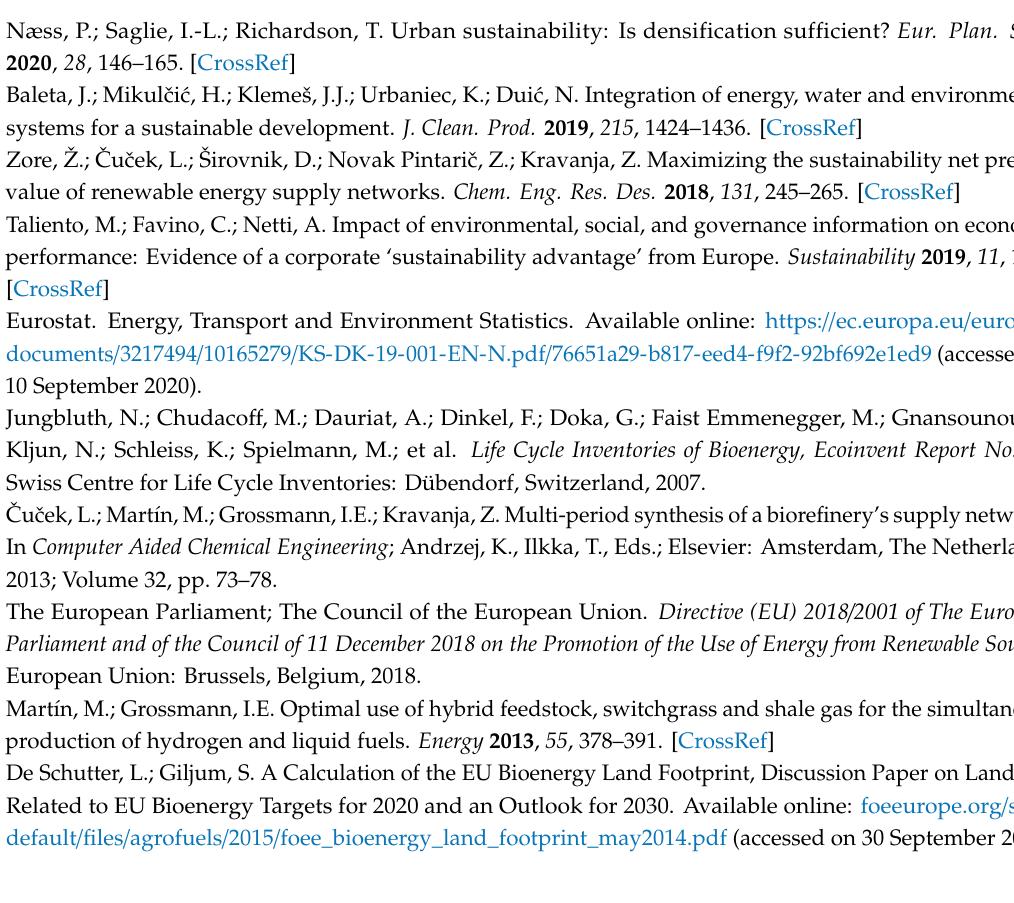
Table S1: Data for regional plan, Table S2: Hectare yields (in 1000 t / (km 2 · year)) and harvesting periods for raw materials, Table S3: Eco-cost coe ffi cients of raw materials (in € / kg), Table S4: Eco-cost coe ffi cients of products (in € / kg), Table S5: Eco-cost coe ffi cients of pre-treatment for various raw materials (in € / kg), Table S6: Data related to technologies for bioethanol, FT-diesel and hydrogen production, Table S7: Data related to technologies for biodiesel production, Table S8: Costs of the storage, pre-treatment and biomass deterioration percentage, Table S9: Operating costs of the processing technology, Table S10: Transportation cost, Table S11: Gross and net wages in EU Member